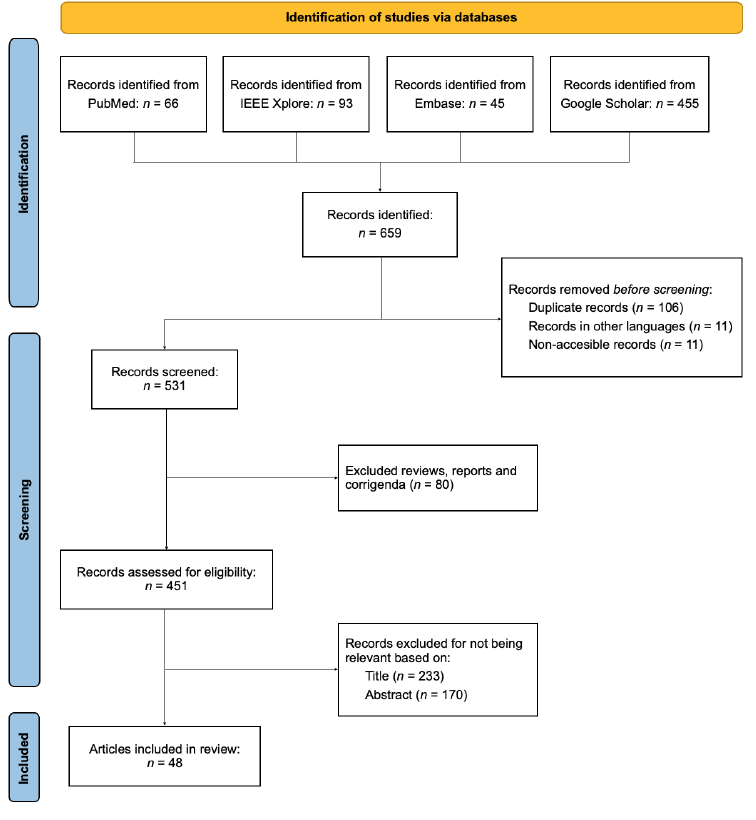
Figure 1. Flowchart summarizing the search and selection process of the reviewed papers.